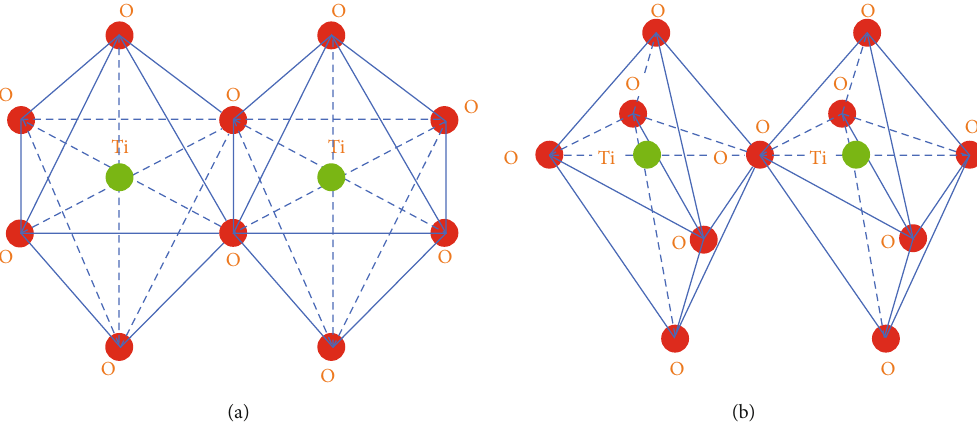
Figure 4: A schematic diagram of nanosized titanium dioxide structure connection. (a) Coedge way. (b) Concurrent way. Table 4: Crystallographic data of di ff erent TiO polymorphs. 2